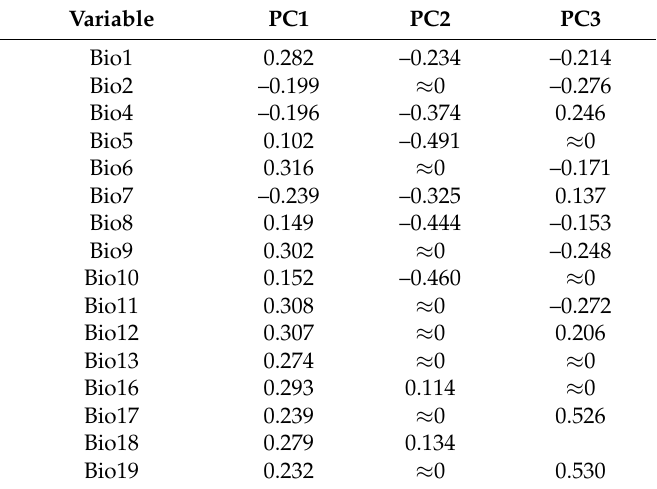
Table A1. Loading factors of 16 bioclimatic variables used in the principal component analysis.